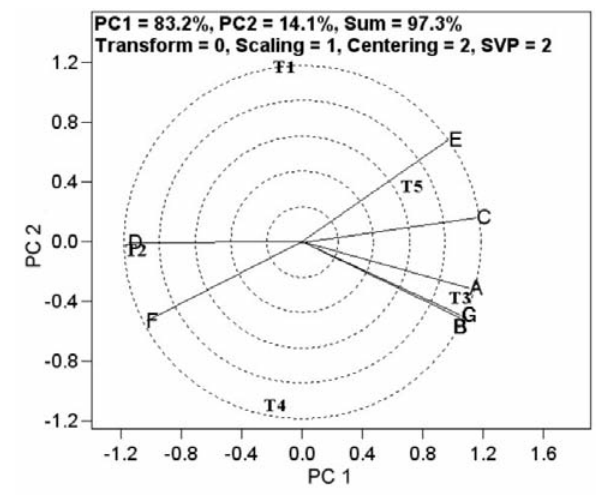
Figure 2. Correlations among different treatments and their effects on morphological growth parameters of marigold seedling. A, seedling biomass; B, root biomass; C, stem diameter; D, plant height; E, leaf area; F, days taken to start blooming; G, seedling